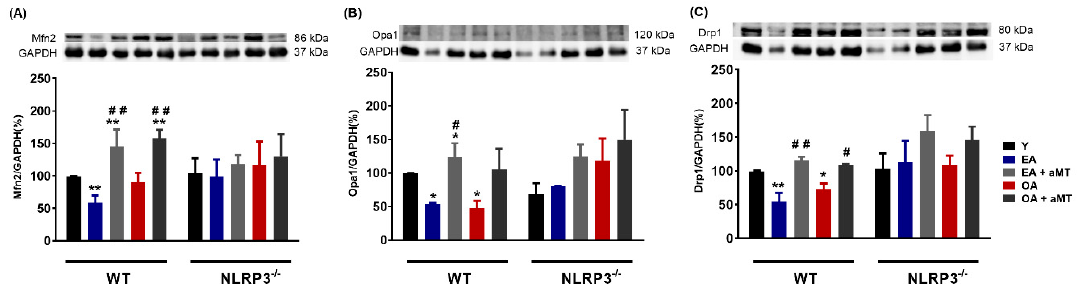
Figure 2. Changes in mitochondrial dynamics (fusion/fission) in WT and NLRP3 − / − mice during aging and melatonin treatment. ( A ) Protein levels of Mfn2. ( B ) Protein levels of Opa1. ( C ) Protein levels of Drp1. Experiments were performed in hearts of young (Y), early-aged (EA), early-aged with melatonin (EA + aMT), old-aged (OA), and old-aged with melatonin (OA + aMT) wild type and NLRP3 − / − mice. Data are expressed as means ± SEM ( n = 7 animals/group). * p < 0.05, ** p < 0.01 vs. Y; # p < 0.05, ## p < 0.01 vs. group without melatonin treatment.